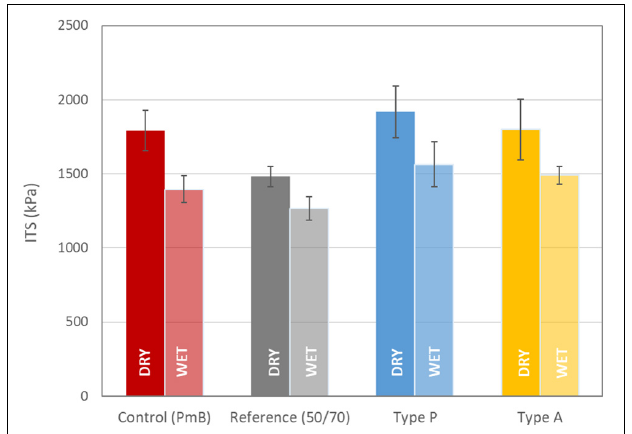
FIGURE 5 | Water sensitivity testing results by using ITSR